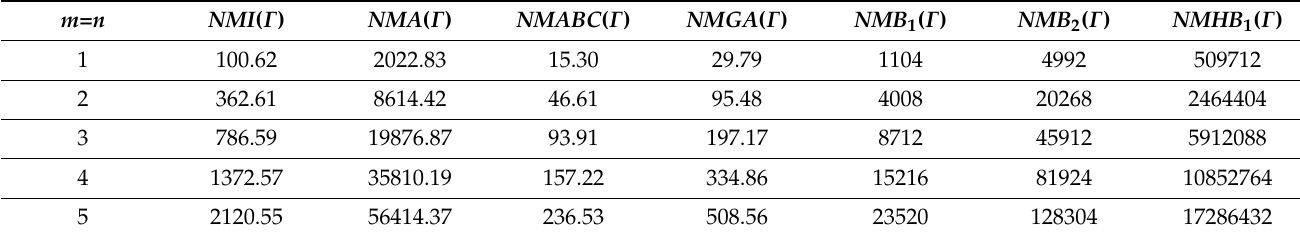
Table 4. Comparison Table for Theorem 2.